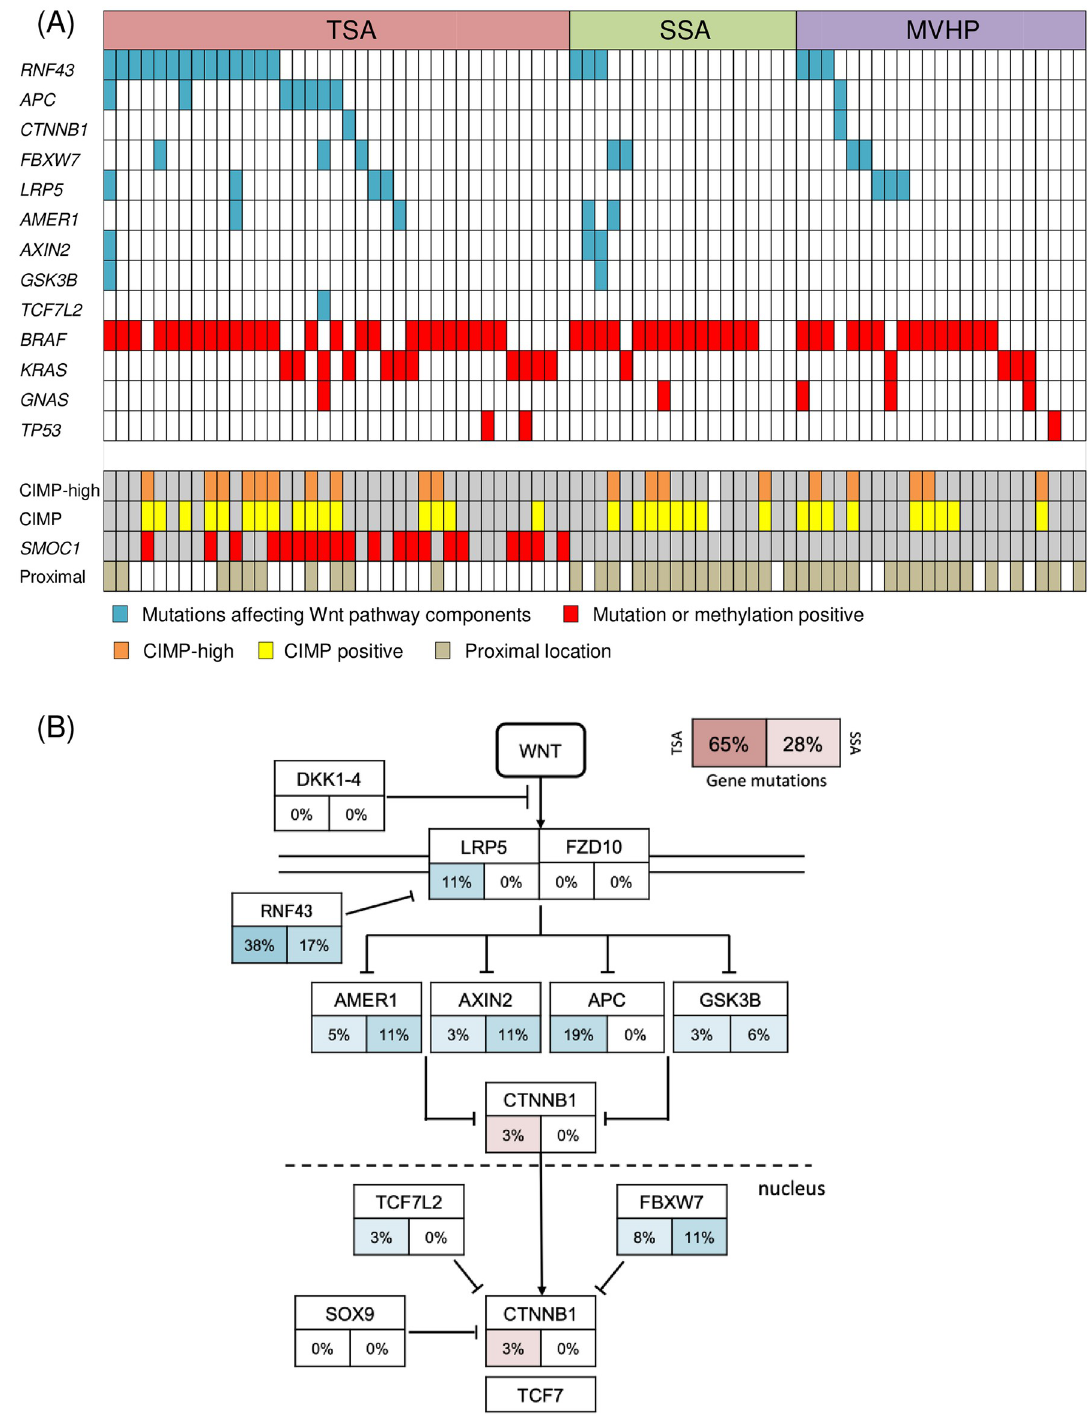
Fig 3. Gene mutations leading to dysregulation of Wnt signaling pathway in serrated lesions. (A) Representative mutation and methylation profile across 78 serrated lesions. Blue coloration indicates gene mutations affecting Wnt pathway components, while red coloration indicates positivity for gene mutations or methylation. (B) Frequencies of gene mutations leading to dysregulation of Wnt signaling in TSAs and SSAs. Alteration frequencies are expressed as percentages of all cases. Frequencies of gene mutations in TSAs are shown on the left, while those in SSAs are shown on the right. Red denotes activated genes and blue denotes inactivated genes.